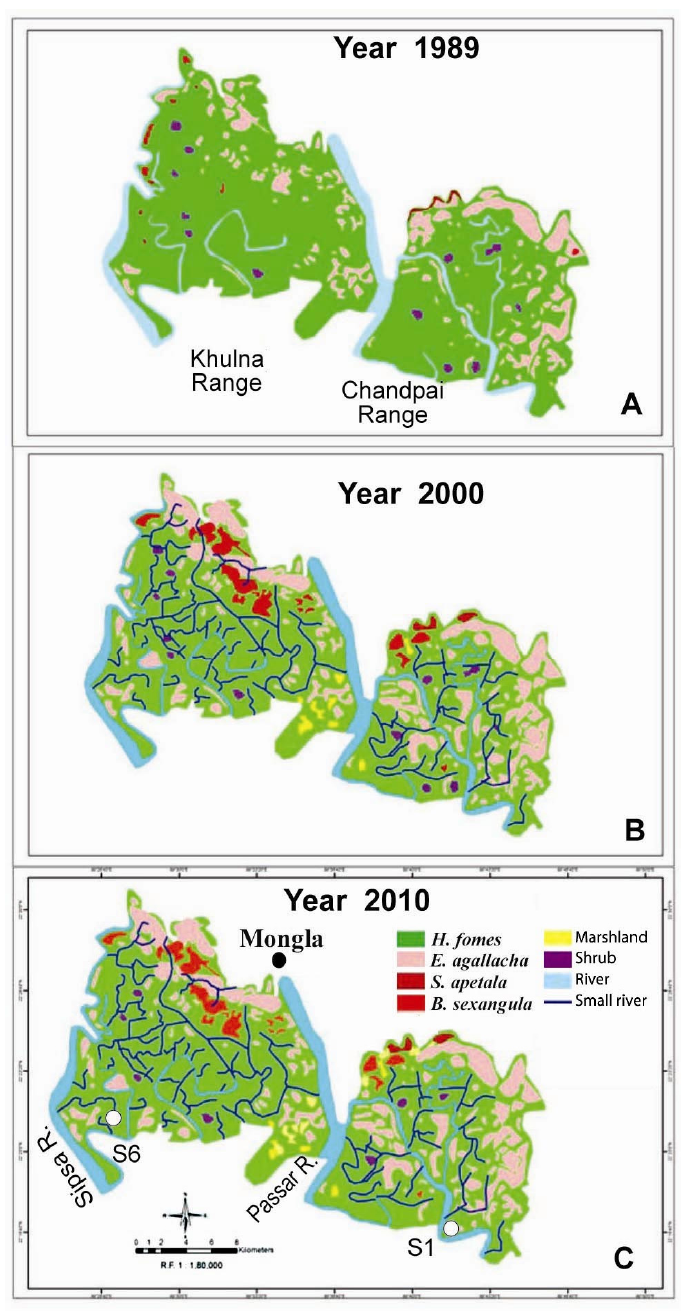
Figure 4. Landsat TM and Landsat ETM + images, showing changes in species composition of parts of forests of Khulna and Chandpai Ranges in 1989 ( A ), 2000 ( B ) and 2010 ( C ) of BSMF [29]. Detail data of the images is given in Table